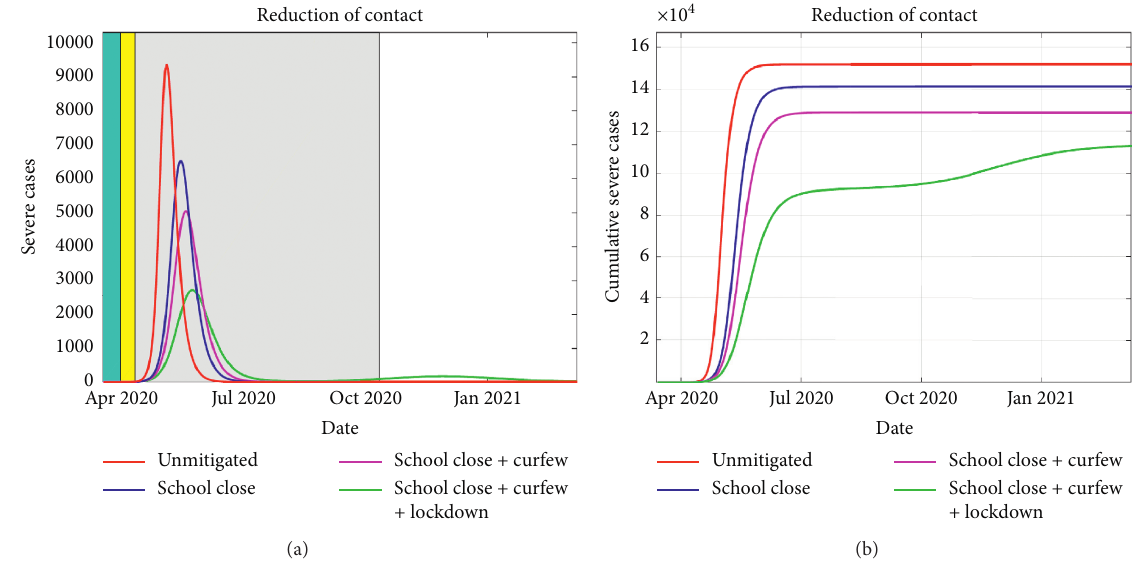
Figure 7: Over the duration of the implementation of the NPIs, the daily severe cases are shown in (a) where the duration of these interventions is indicated by the colored region. In (b), the cumulative severe cases for the three mitigation measures are shown. It shows that the implementation of the three measures leads to a reduced number of severe